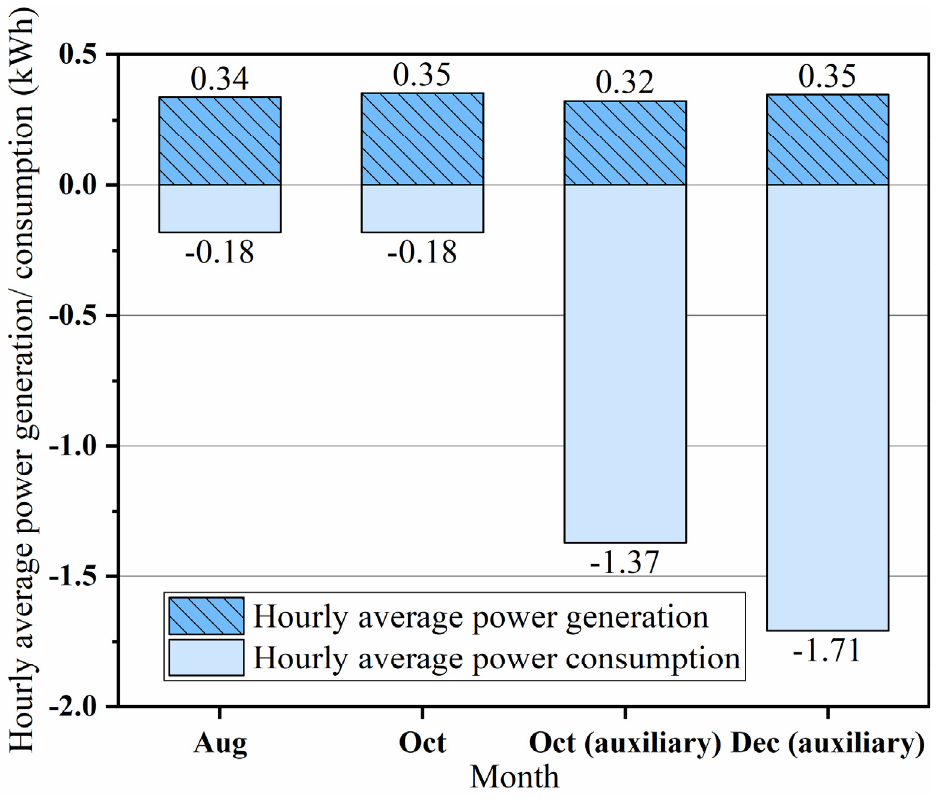
Figure 11. The hourly average power generation and power consumption of the system.